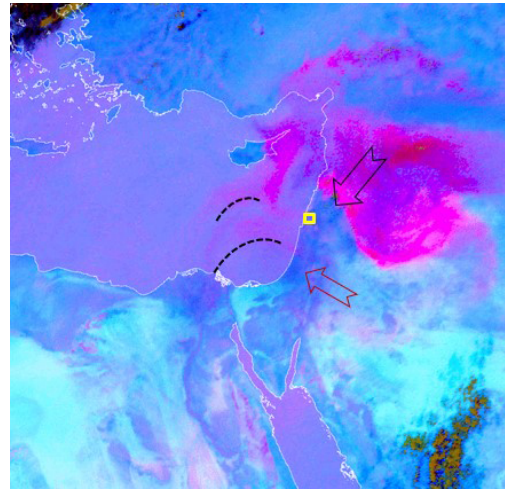
Figure 14. Picture from the MSG-SEVIRI satellite of the dust RGB component (dust appears in pink colors) on 7 September 2015 at 12:00UTC with indications of the Mount Meron ceilometer site (yellow square: longitude 33.0 ◦ , latitude 35.4 ◦ ) and the dust plumes’ progression from east to west (red arrow and dashed lines) and from the northeast to southwest (black